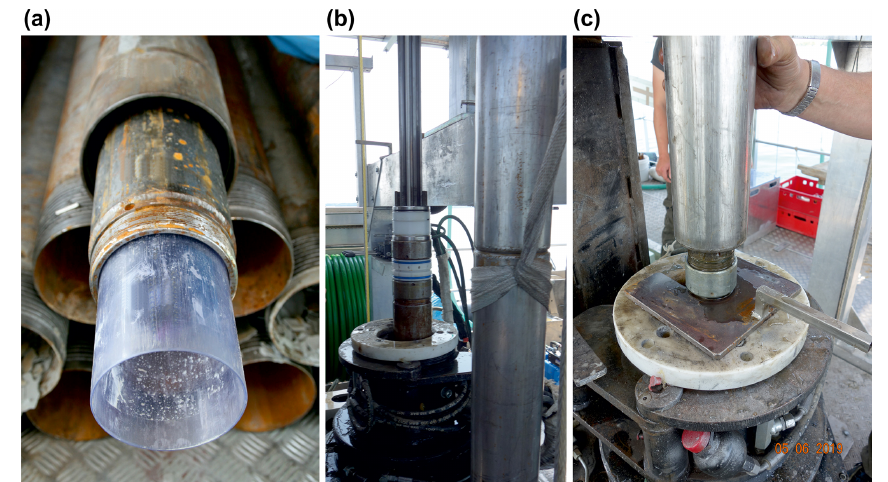
Figure 4. Casing, core barrel, and inner liner before setup (a) . Coring assembly lowered into the lake with the connection of the core barrel with the DTH hammer atop the rotary unit (b) . Heavyweight rods above the hammer unit hold the rotary unit in place through a makeup plate (c) .